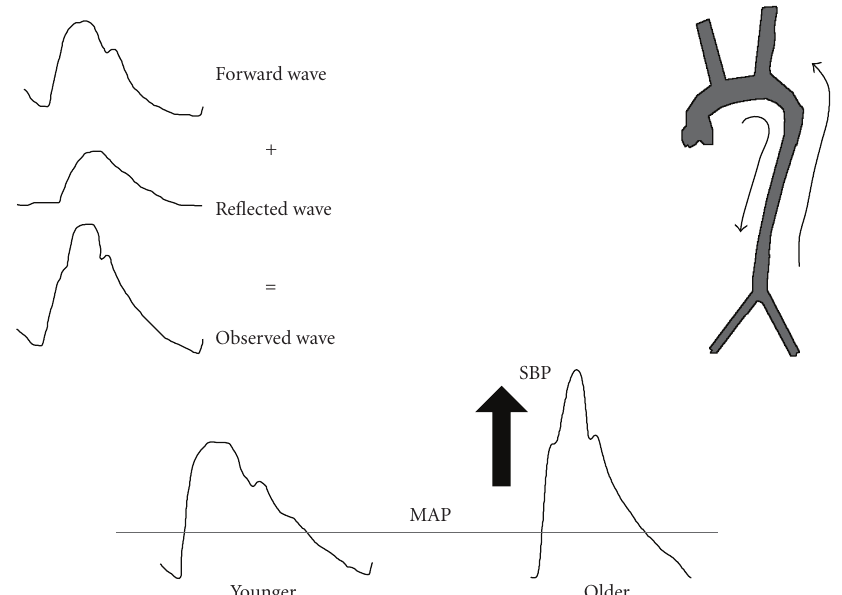
Figure 1: This figures illustrates the composition of the arterial pressure waveform from a combination of a forward pressure wave created by ventricular contraction and a reflected wave. MAP: mean arterial pressure; SBP: systolic blood pressure (see